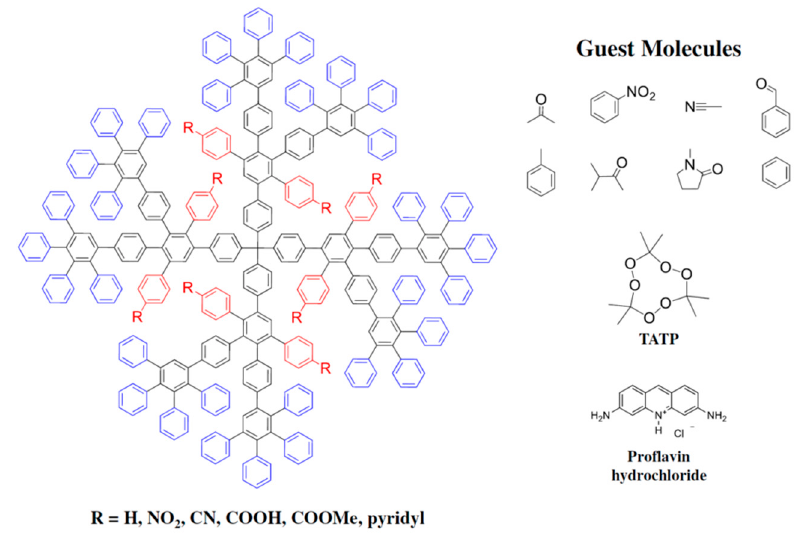
Figure 46. Various poly(phenylene) (PPD) sca ff oldings modified with polar groups and non-polar groups to tailor their encapsulation properties toward various polar / non-polar guest molecules. Reprinted with permission from [190]. Copyright 2016 American Chemical